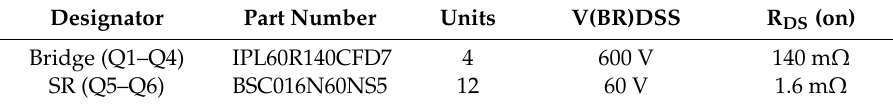
Table 5. Primary side HV MOSFETs and SRs MOSFETs in optimized design.